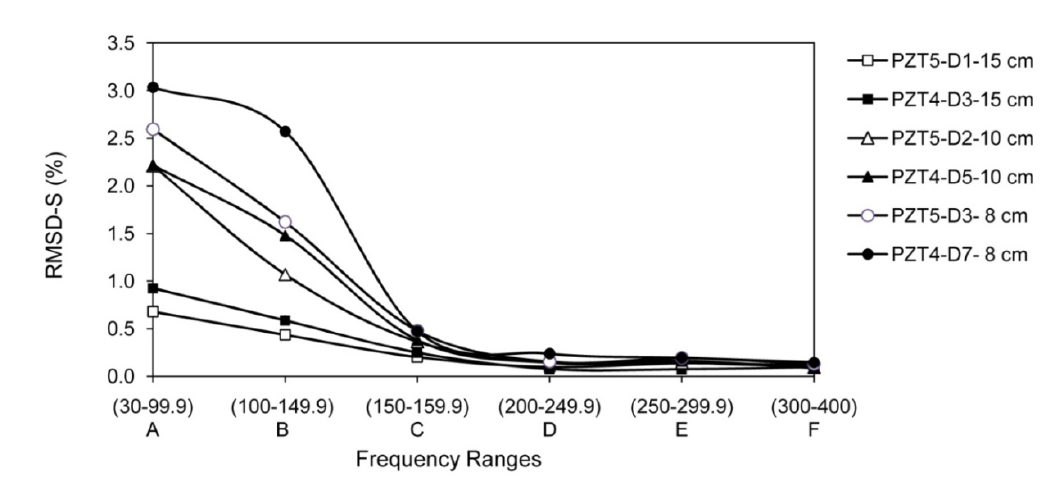
Figure 12. RMSD-S for PZTs 4 and 5 for similar distance to